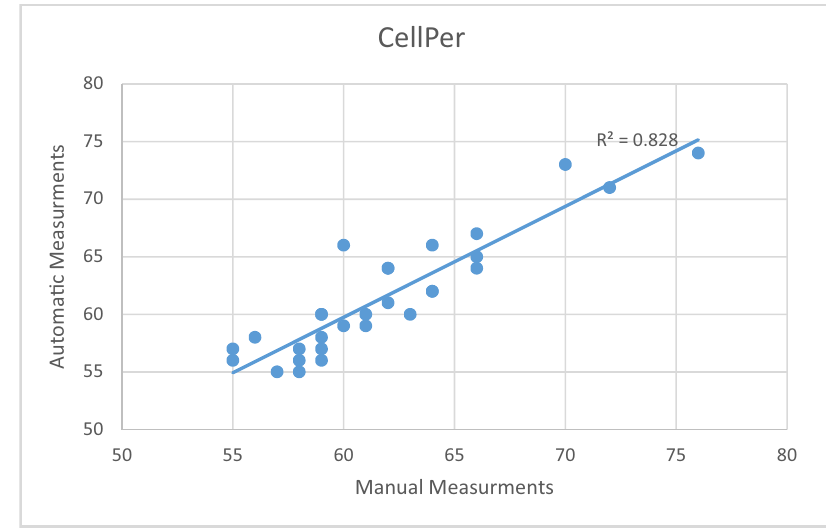
Figure 18: Correlation for the cell per feature for the segmented images.